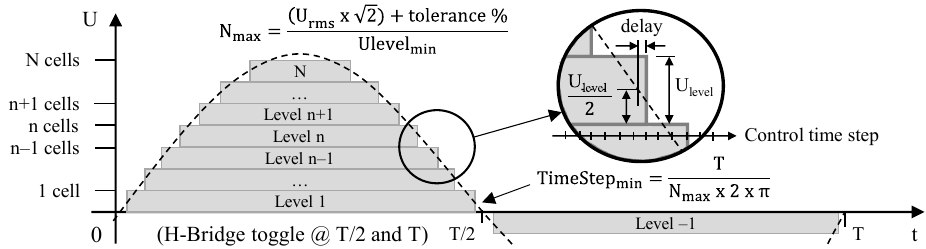
Figure 1. Staircase shape sine waveform generated by N-level Self-Reconfigurable Batteries (SRB). A High Frequency Self-Reconfigurable Battery (HF SRB) was recently proposed in [9]. This SRB relies on a Nearest Level Control (NLC) to allow the integration of the switches control in low cost microcontrollers. This study demonstrated the operation of a prototype of 128 cells recharging directly on the electrical grid without charger, while per- fectly balancing the cells in real-time. Its operating principle is detailed in Section 2.